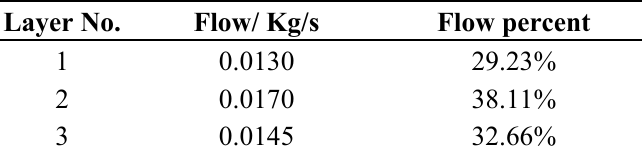
Table 5. Flow distribution results.